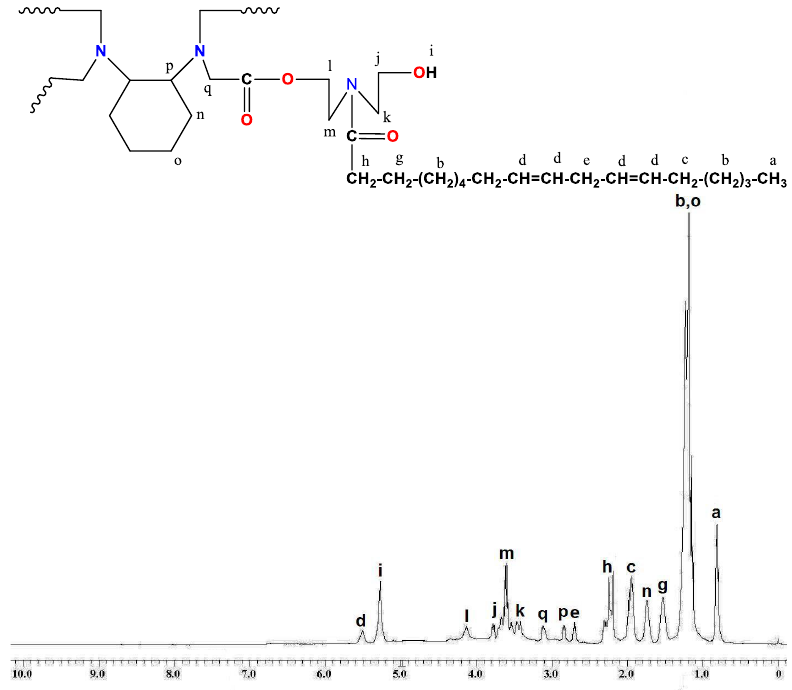
Figure 3. 1 H NMR spectra of PDCEA Figure 3: 1 H NMR spectra of